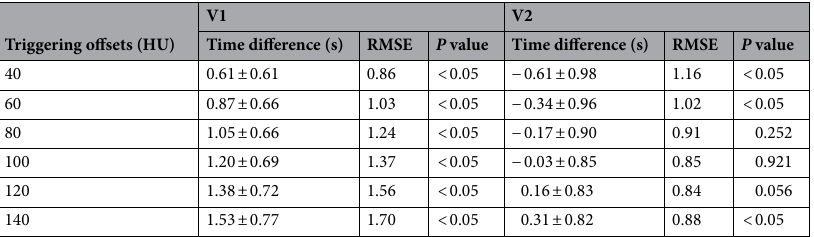
Table 2. Simulated prospective acquisition time versus optimal acquisition time. The “Time Difference” shows the time difference between each bolus-tracking simulation and the optimal acquisition timing. The optimal acquisition timing is obtained from the gamma variate fitting AIF curve, where V1 at the second derivative peak of AIF and V2 at the AIF peak. RMSE root mean square error. If the p-value is 0.05 or lower, the result is considered as significant